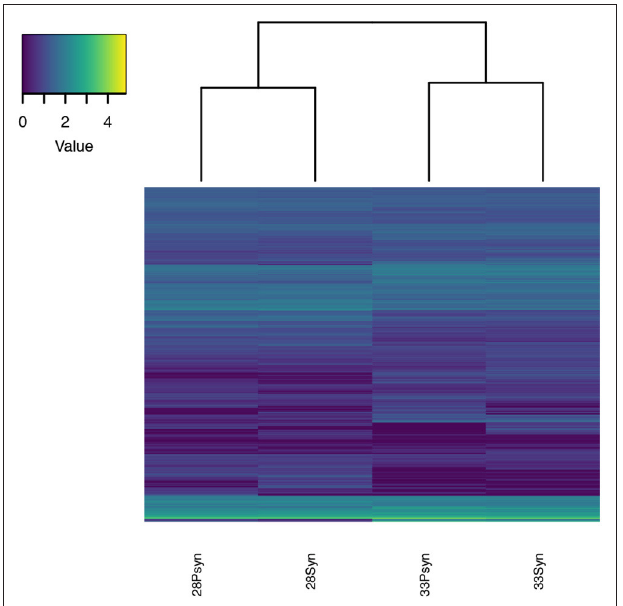
FIGURE 9 | Heatmap of normalized expression. Expression levels for the four samples are similar, which is expected since the samples are from the same tissue type. The samples cluster in pairs by stage with the stage 28 and stage 33 sample expression being more similar to each other than to the other stage.